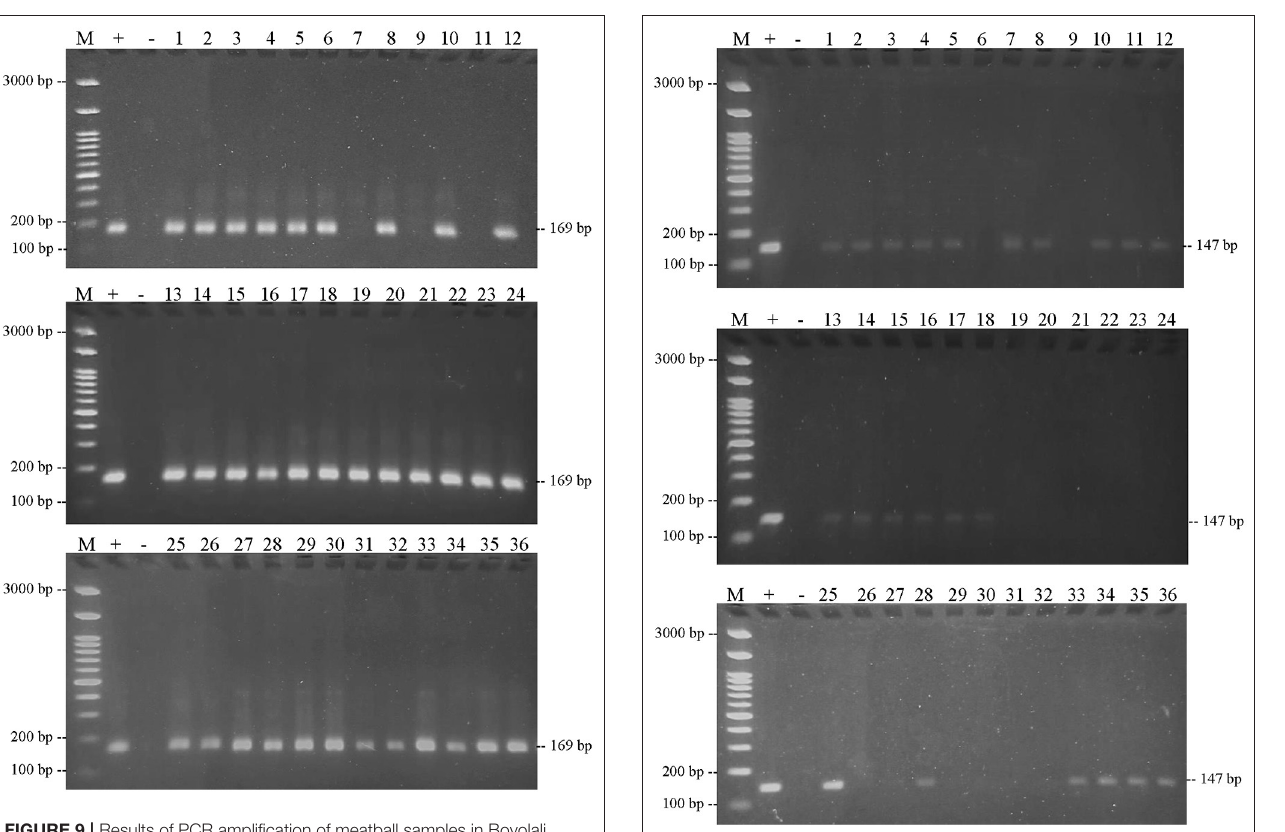
FIGURE 9 | Results of PCR amplification of meatball samples in Boyolali Regency with chicken primers and electrophoresis on 2% agarose gels. (M) DNA marker 100 bp; ( + ) positive control meatballs; (–) negative control (no template control); samples were coded with numbers L1–L36. adulteration of the meat with beef and pork to earn more profits.